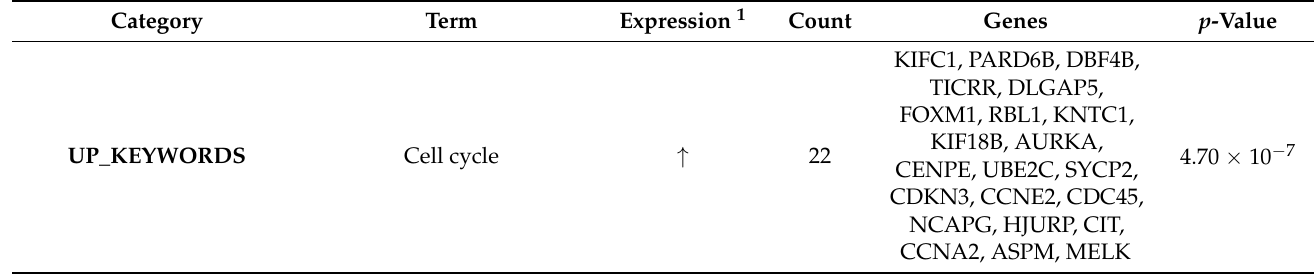
Table 2. Enrichment analysis of up-regulated (N = 204) and down-regulated (N = 206) genes in germline-mutated MBCs compared with non-mutated MBCs. Only the terms considered as the most representative and interesting among the significant ones are